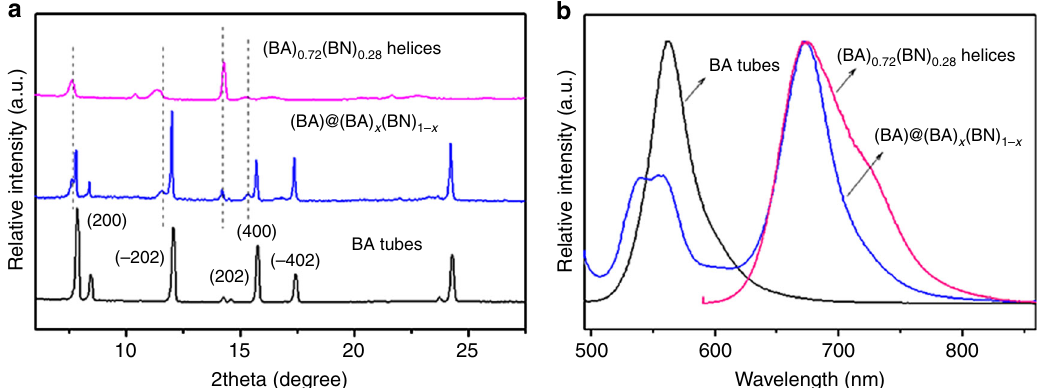
Fig. 8 XRD and PL characterization of BA tubes, (BA) 0.72 (BN) 0.28 helices, and BA@(BA) x (BN) 1- x core-shell structures. a XRD patterns of BA tubes, (BA) 0.72 (BN) 0.28 , and BA@(BA) x (BN) 1- x core-shell structures obtained by mixing BA tubes with 2 mL of a saturated supernatant of (BA) 0.72 (BN) 0.28 alloy helices. The dashed lines represent the peaks of (BA) x (BN) 1- x shell. b The corresponding PL spectra when excited by 480